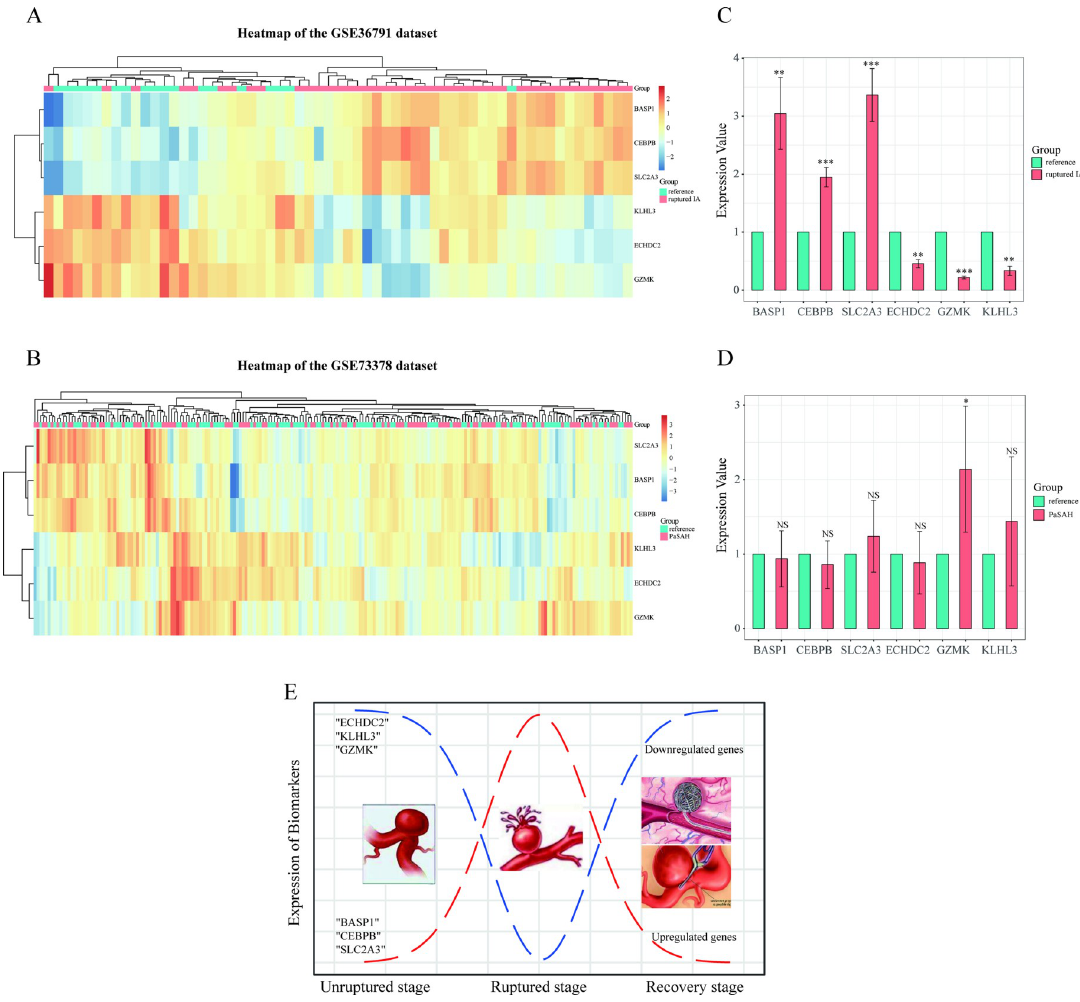
Fig 5. Heat maps show the expression profiles of the six candidate biomarker genes in the GSE36791 (A) and GSE73378 (B) datasets. Orange and blue coloring indicates high and low expression values, respectively. In the GSE36791 dataset, there is a mixture of ruptured aneurysm samples in the reference group. However, a good cluster was still obtained for the ruptured IA group compared to the GSE73378 dataset. (C, D) Validation of gene expression levels for BASP1 , CEBPB , SLC2A3 , ECHDC2 , GZMK , and KLHL3 in ruptured IA (or PaSAH) and reference samples. Data are presented as 2 - ΔΔ CT relative to GAPDH . � P < 0.05, �� P < 0.01, ��� P < 0.001, NS: not significant. (E) A representation of the biological events which occur during IA rupture through recovery, with gene regulation of the six relevant genes identified in the present study shown as